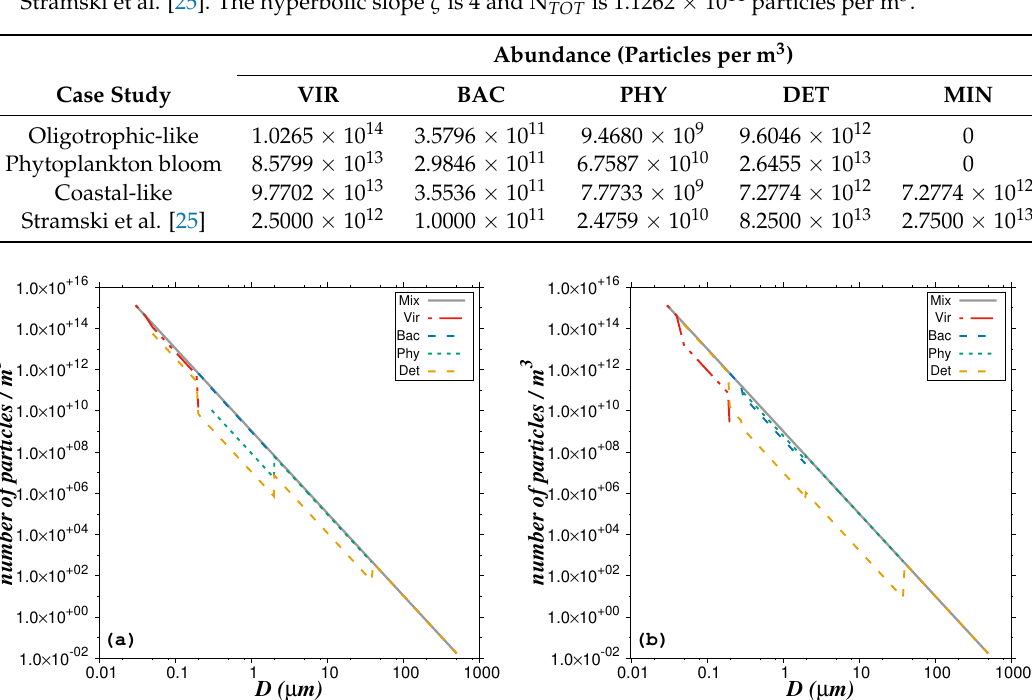
Table 6. Comparisons between abundances defined in the present study and abundances defined by Stramski et al. [25]. The hyperbolic slope ξ is 4 and N TOT is 1.1262 × 10 14 particles per m 3 .